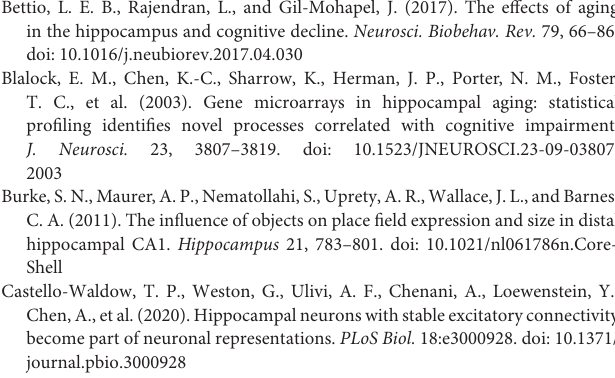
Supplementary Figure 1 | ADMP training does not change the proportion of Arc + neurons after novel box exploration . (A) Arc mRNA expression in cytoplasm nuclei was used to quantify neuronal activation after novel box exploration during epoch 1 or epoch 2, respectively. (B) An example of Arc + CA1 neurons (red). A scale bar: 10 µ m. (C) ADMP training did not change the percentage of Arc + neurons activated by novel box exploration during epoch 1. (D) ADMP training did not change the percentage of Arc + neurons activated by novel box exploration during epoch 2. Supplementary Figure 2 | Evaluation of different methods for catfish analysis. (A-D) Manual detection of overlapping CA1 neurons after re-exposure to the same novel box. (A) Left. Percentage of neurons expressing Arc in cytoplasm (with and without co-expressing Arc in foci) showed increase by novelty during epoch 1. Right. Percentage of neurons expression Arc in foci (with and without co-expressing Arc in cytoplasm) showed increase by novelty during epoch 2. (B) Left. Percentage of neurons expressing Arc only in cytoplasm (without co-expressing Arc in foci) showed increase by novelty during epoch 1. Middle. Percentage of neurons expressing Arc only in foci (without co-expressing Arc in cytoplasm) showed increase by novelty during epoch 2. Right. Percentage of neurons co-expressing Arc in cytoplasm and foci showed an increase when novelty was introduced two times. (C) Left. Percentage of neurons expressing H1a (with or without co-expressing Arc ) showed increase by the novel box exploration in epoch 1. # 1 , Box + HC vs. HC + Box, p = 0.054. Right. Percentage of neurons expressing Arc (with or without co-expressing H1a ) showed increase by the novel box exploration in epoch 2. (D) Left. Percentage of neurons expressing H1a only (without co-expressing Arc ) showed increase by novelty during epoch 1. # 2 , Box + HC vs. Box + Box, p = 0.075. Middle. Percentage of neurons expressing Arc only (without co-expressing H1a ) showed increase by novelty during epoch 2. Right. Percentage of neurons co-expressing H1a/Arc showed an increase when novelty was introduced two